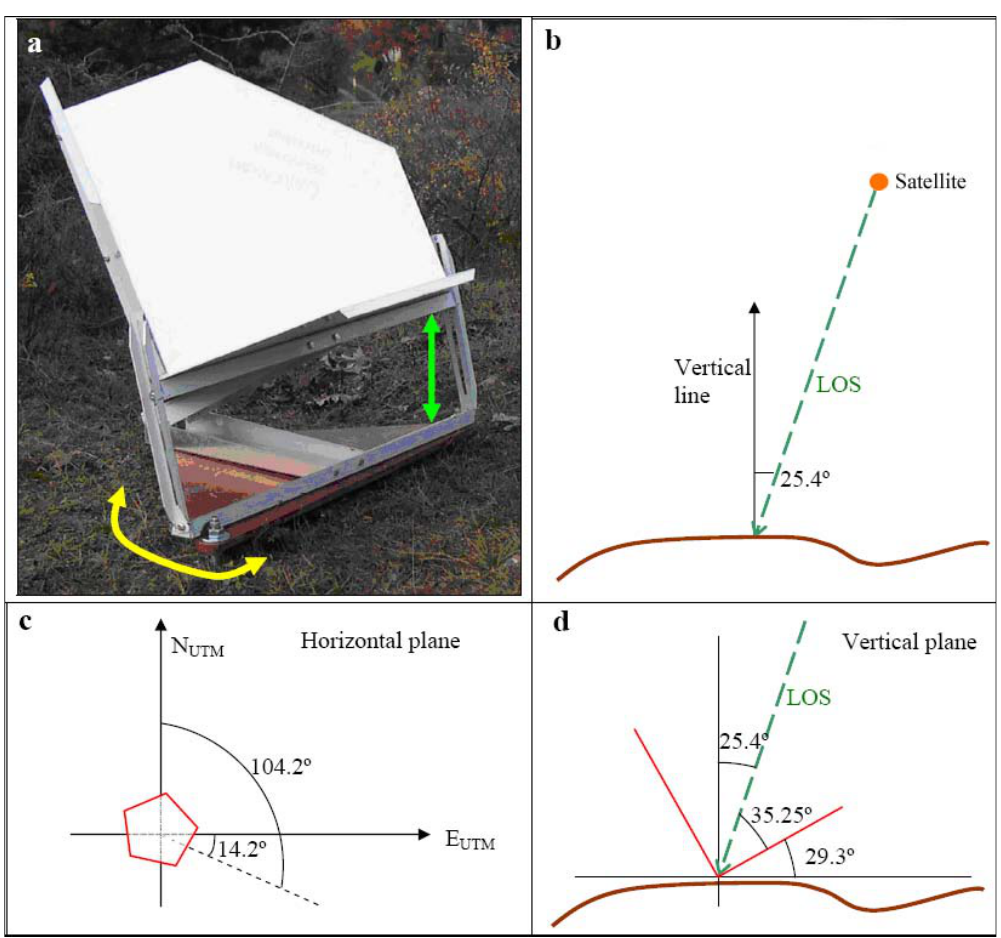
Fig. 3. Geometry of the Corner Reflectors (CRs): (a) The CRs need to be oriented perpendicular to the trajectory of the satellite for the planimetric orientation (yellow arrow). The vertical position (green arrow) should be related to the incidence angle of the SAR acquisition; (b) geometry of the acquisition; (c) planimetric geometry; (d) geometry in the vertical plane.